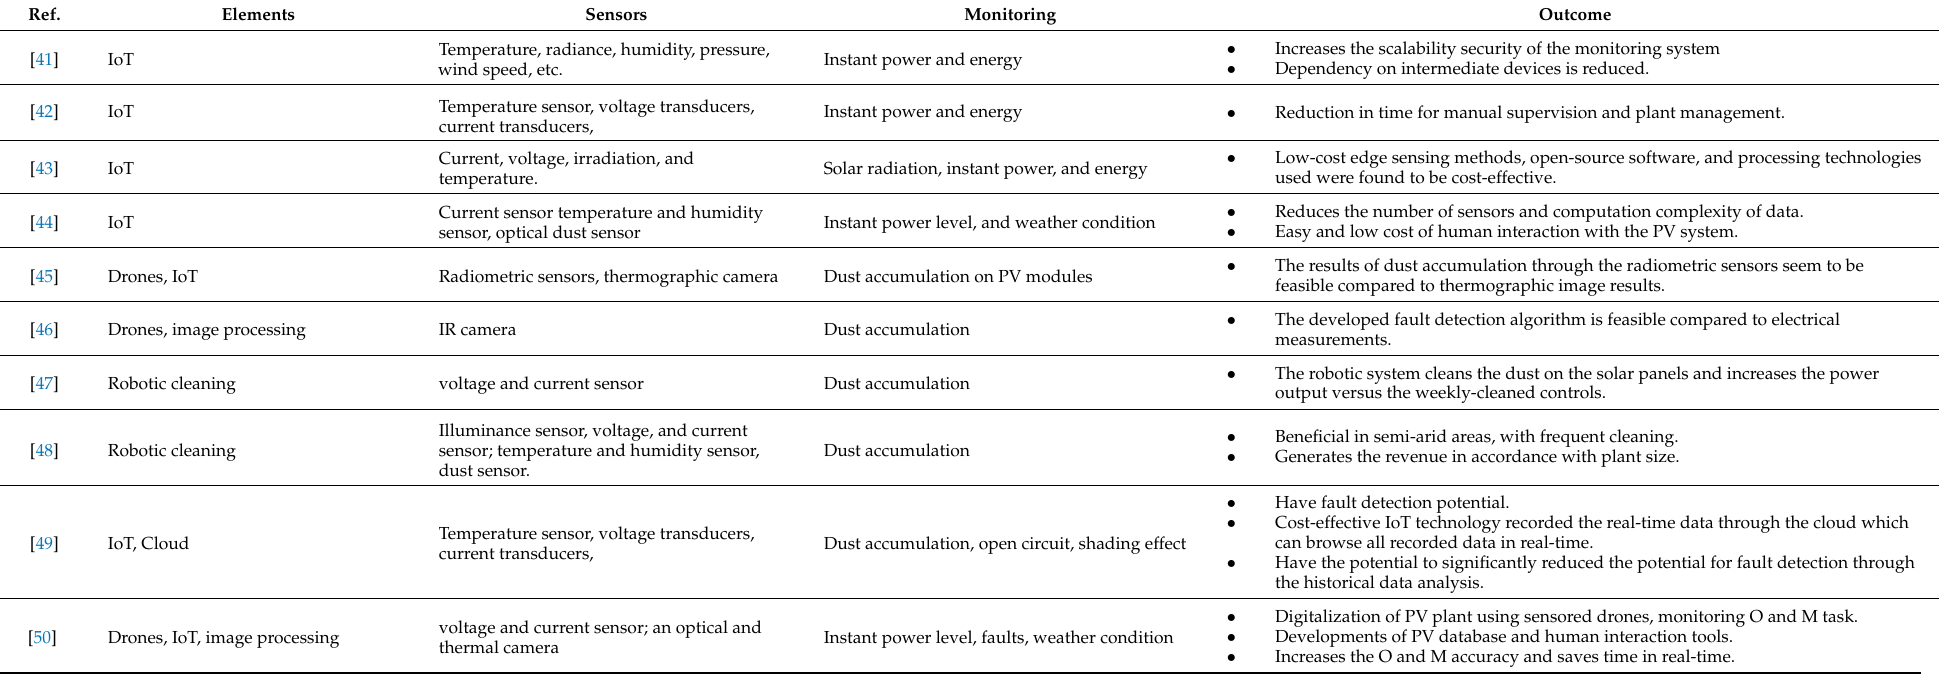
Table 3. Recent technologies and applications of digitalization involved in PV